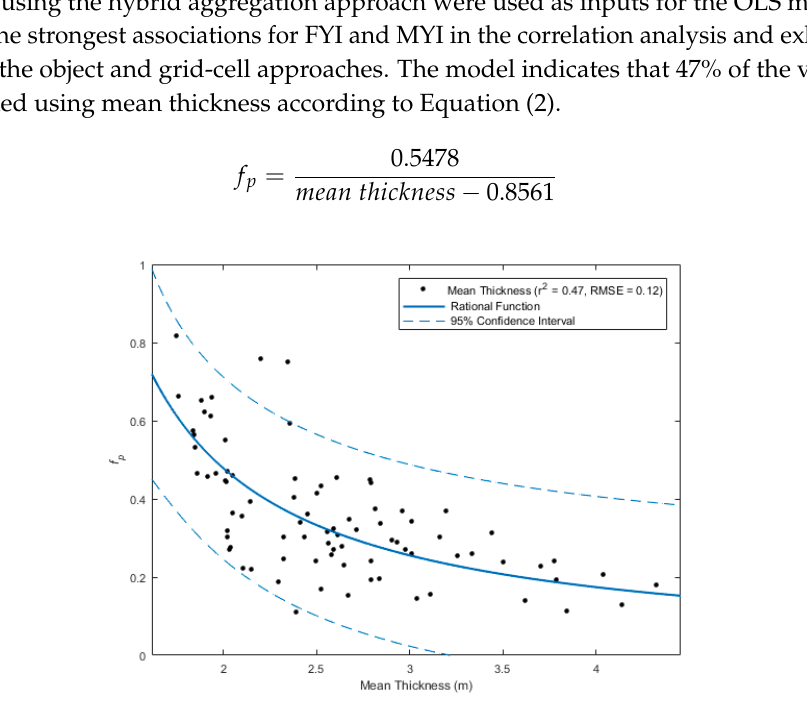
Figure 8. A rational function OLS model of f p as a function of mean thickness. The data were aggregated using the hybrid-based approach at the medium scale. A rational function has been fitted to the data (solid blue line), with a 95% confidence interval (dashed blue line).